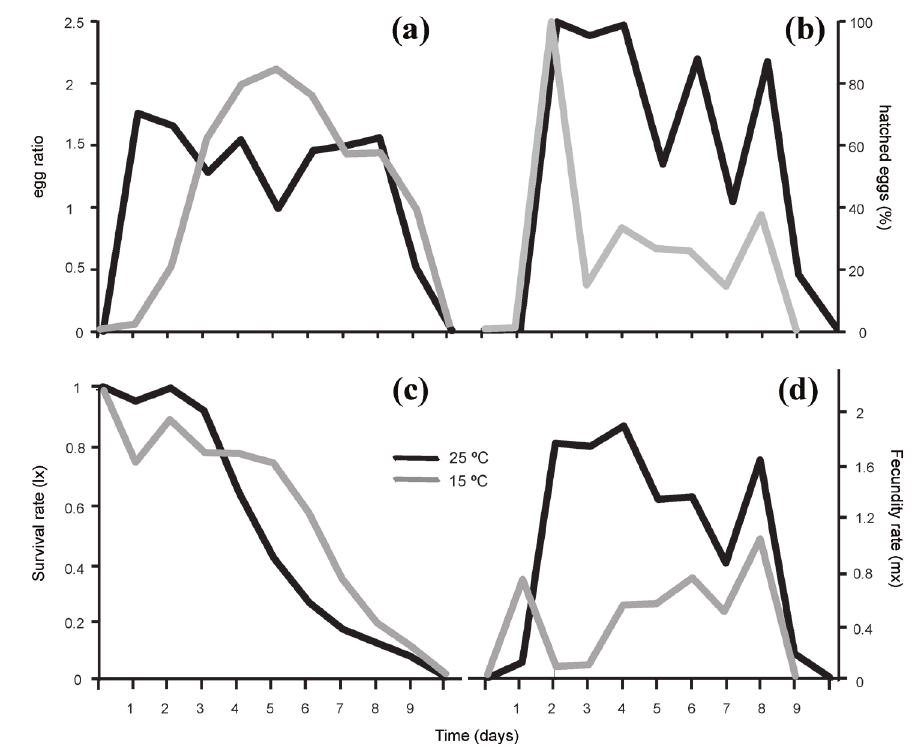
Figure 4 - Comparison between the egg ratio ( a ) and the percentage of hatched eggs per day ( b ), and for the survival rate ( c ) and the fecundity ( d ) of Brachionus plicatilis between the two temperatures tested: 25 ºC (black curves) and 15 ºC (gray curves).